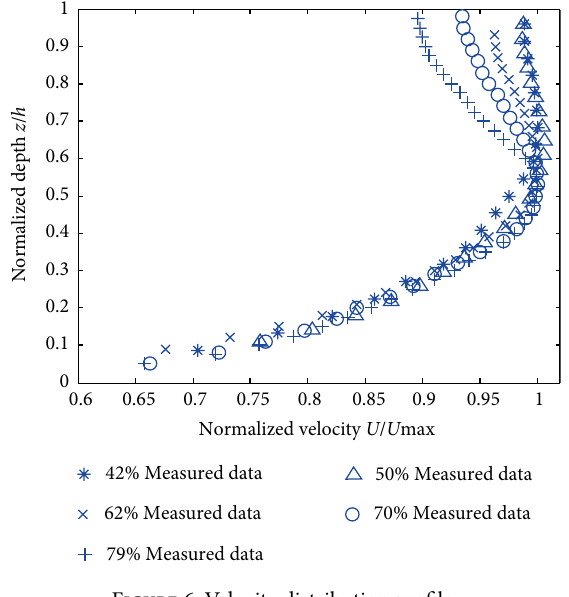
Figure 6: Velocity distribution